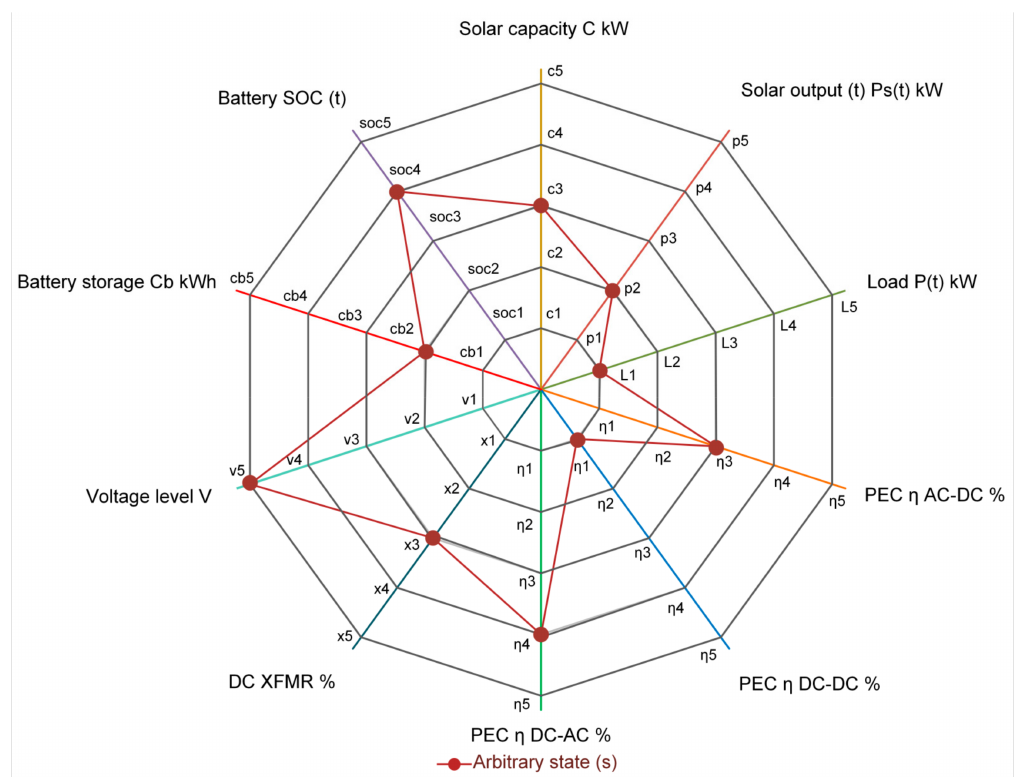
Figure 8. Concept for a multi-parameter multi-value efficiency/energy savings analysis.